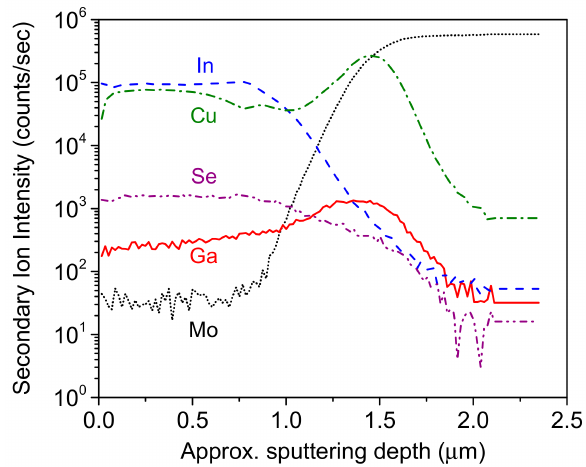
Figure 4. SIMS depth profile of CIGS film with a Ga/(Ga + In) ratio of 0.25 selenized at the Se flow rate of 25